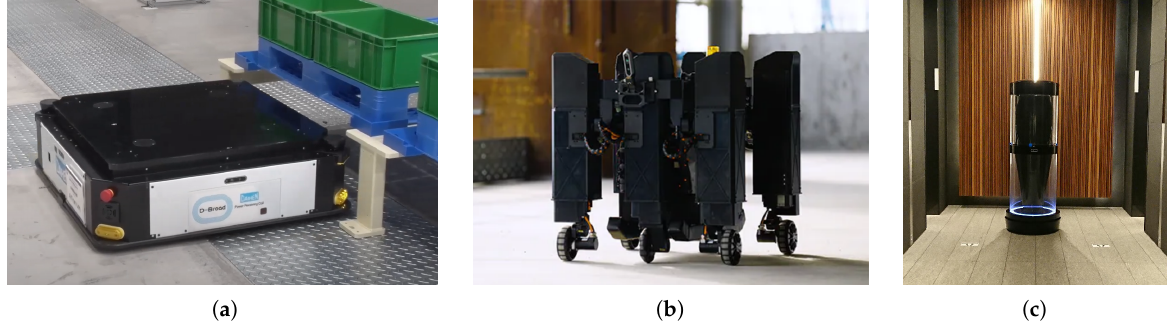
Figure 1. Practical omnidirectional robot. ( a ) “AiTran” developed by DAIHEN Corporation, can be used not only for loading but also for towing cage carts and substituting for forks and can be widely applied to various objects and scenes in factories 1 . ( b ) Robot under development by Sony Corporation and Shimizu Corporation to improve the efficiency of construction management tasks such as patrolling and monitoring at construction sites 2 . ( c ) “Display Robot” developed by THK Corporation and Yoshityu Mannequin Corporation for customer service and advertising activities in commercial facilities, hotels, and airports 3 . ( 1 https://www.youtube.com/watch?v=IPszY3uGrt8, accessed on 19 January 2023. 2 https://www.sony.com/ja/SonyInfo/News/Press/202112/21-1214/, accessed on 19 January 2023. 3 https://products.thk.com/jp/ja/news/products/article-01102020-1.html, accessed on 19 January